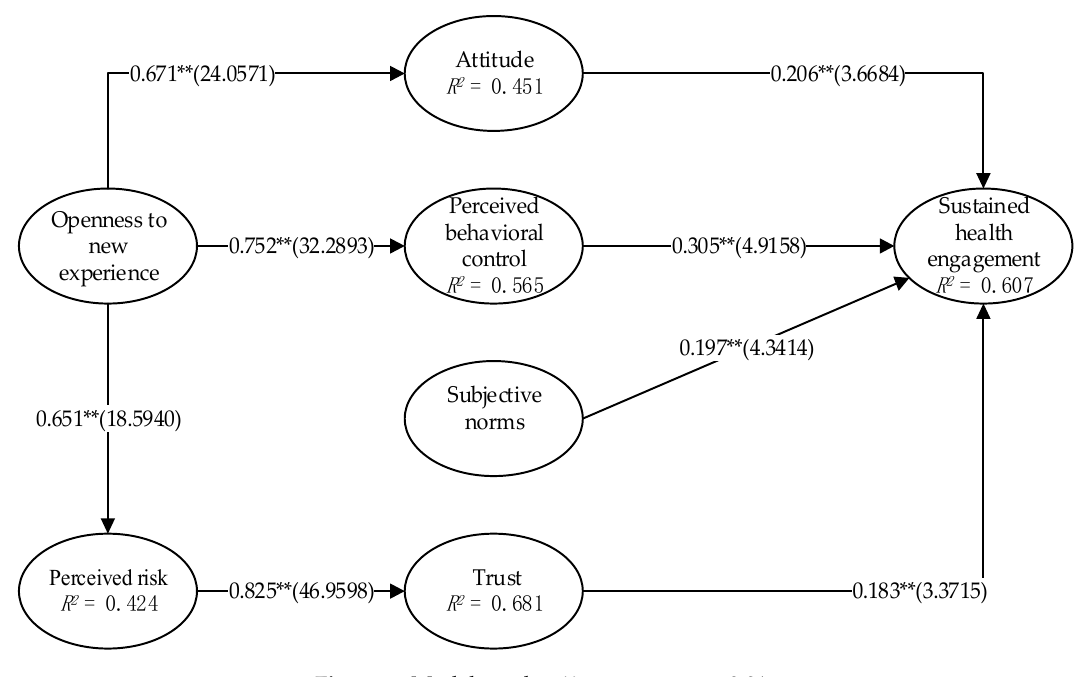
Figure 2. Model results. ** represents p < 0.01. Table 3. Hypothesis testing results of the model.